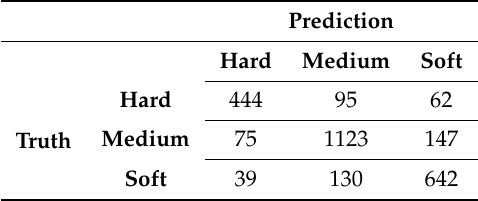
Table 15. Confusion matrix of the predictions of the final trained compound choice NN on the entire database (filtered according to Section